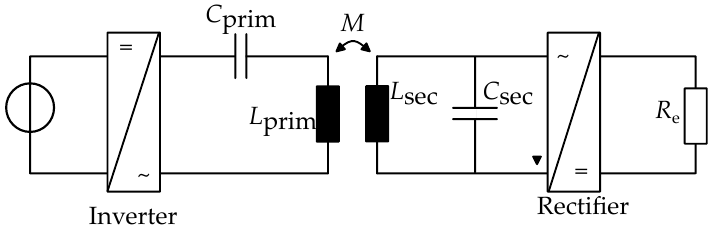
Figure 11. Equivalent circuit of the WPT system.